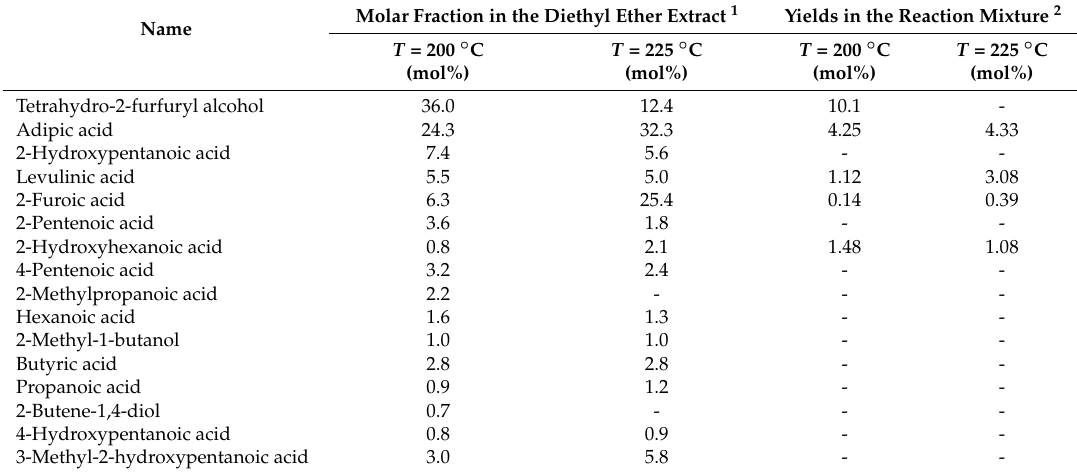
Table 3. Products distribution in the aqueous and extracted phase over NiMo/ γ -Al 2 O 3